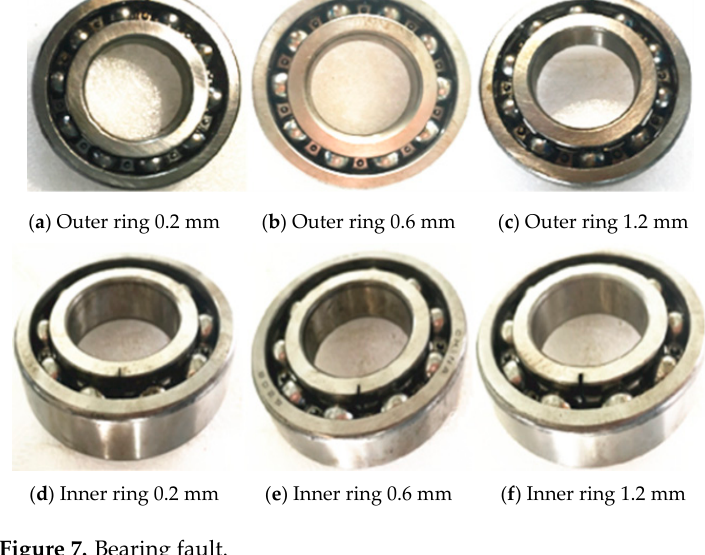
Figure 7. Bearing fault.